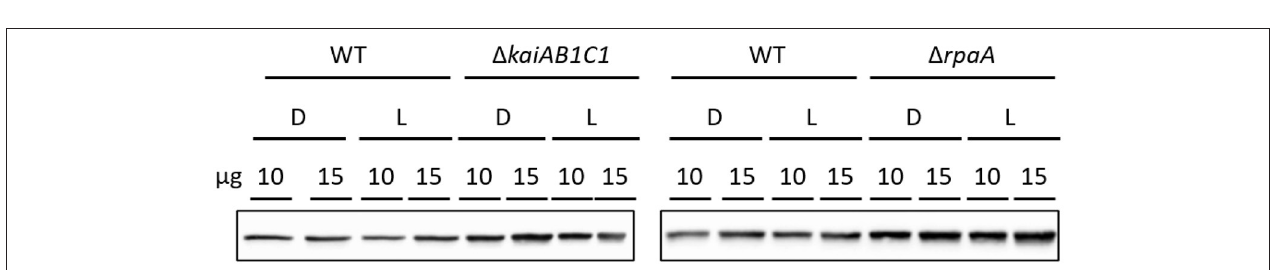
FIGURE 8 | Increased RubisCO abundance in mutants compared to wild type (WT). Comparison of the RubisCO levels via immunoblot analysis using anti-RbcL. Ten or fifteen microgram of crude cell extract were used for SDS-PAGE. The samples were collected 5.5h after the transition to D or L as shown in Figure 4A .